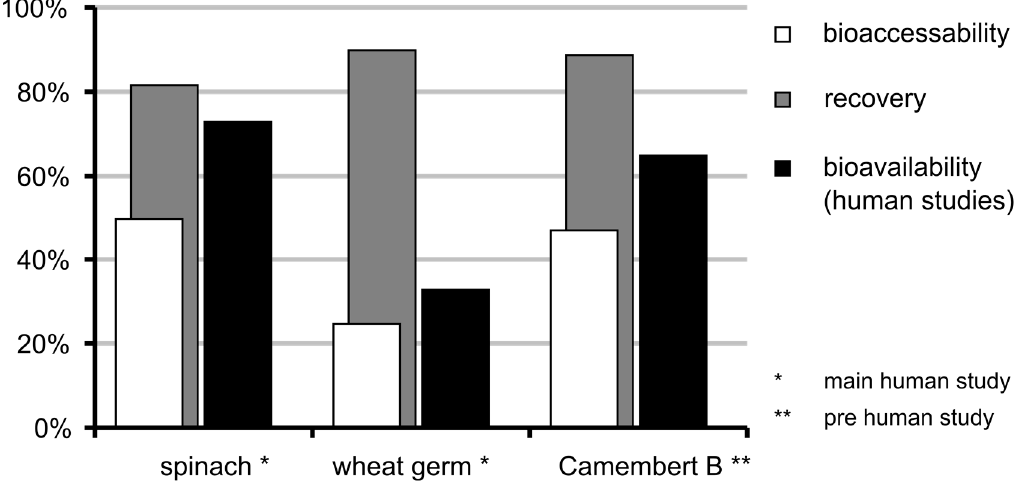
Figure 8. Comparison between bioavailability data from the human study of Mönch et al. [15,16] and data from the in vitro simulation—recovery of folates, taking only the stability into account and bioaccessibility considering both the recovery and the